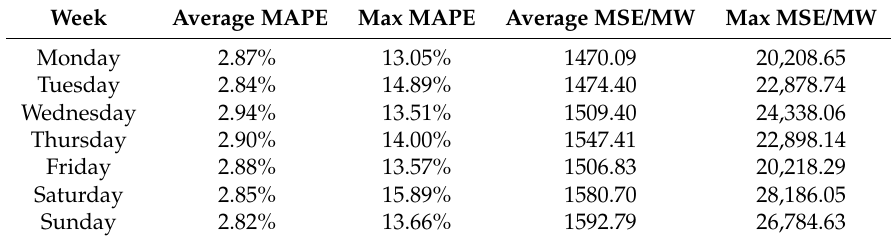
Table 2. The comparison of errors for Monday to Sunday.